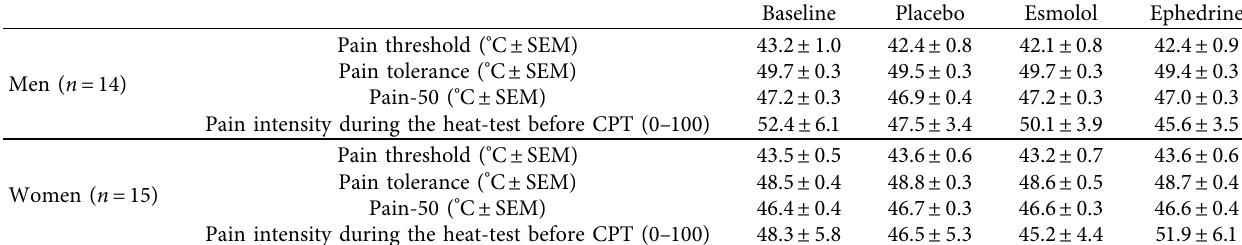
Table 2: Mean pain evaluations for men and women before CPT.